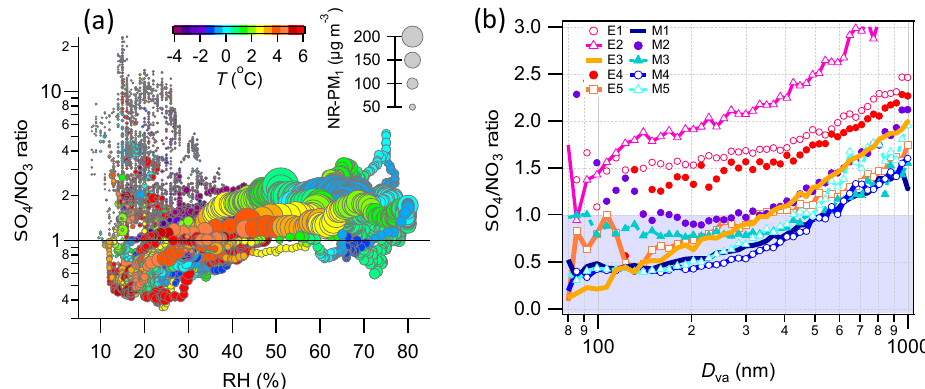
Figure 3. (a) Variations of SO 4 / NO 3 ratios as a function of RH, (b) size-resolved SO 4 / NO 3 ratio during five episodes (E1–E5) with high